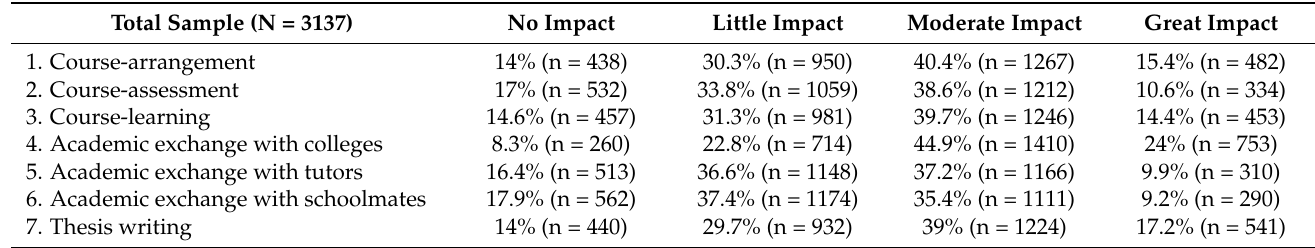
Table 1. The impact of COVID-19 on study variables.